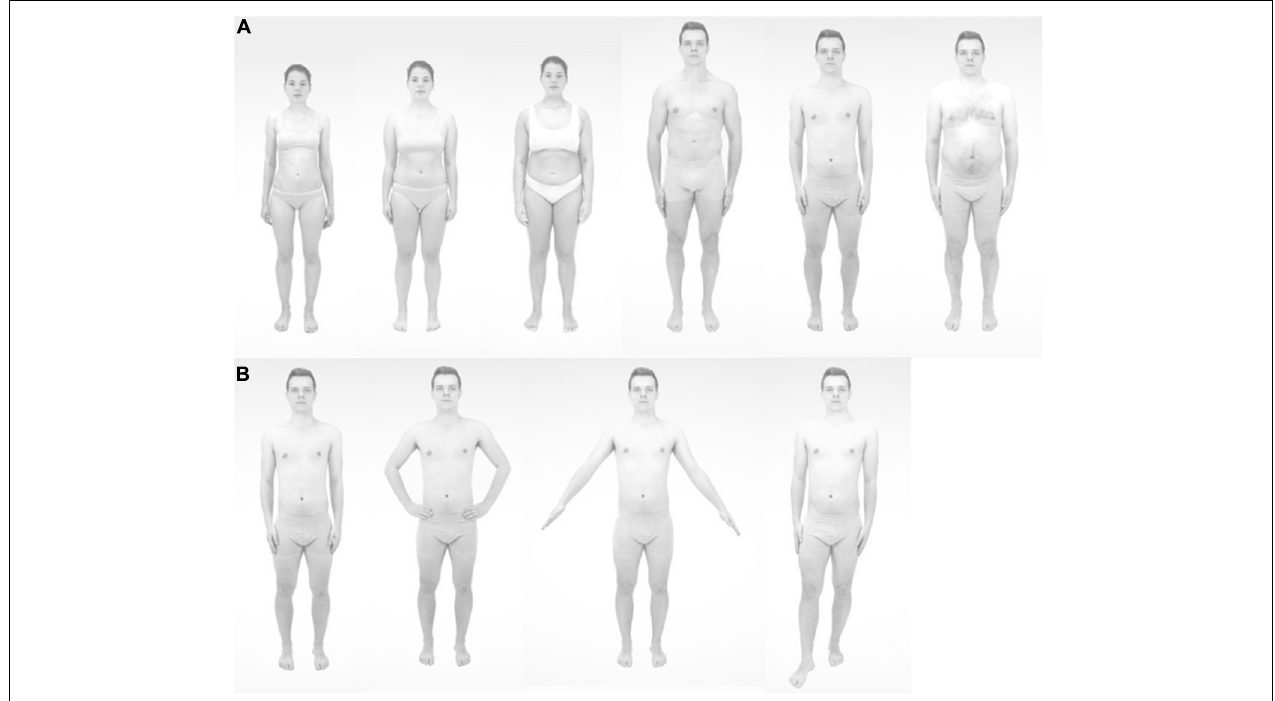
FIGURE 1 | The ideal, average-weight, and overweight female and male bodies (A) and the four poses (B)